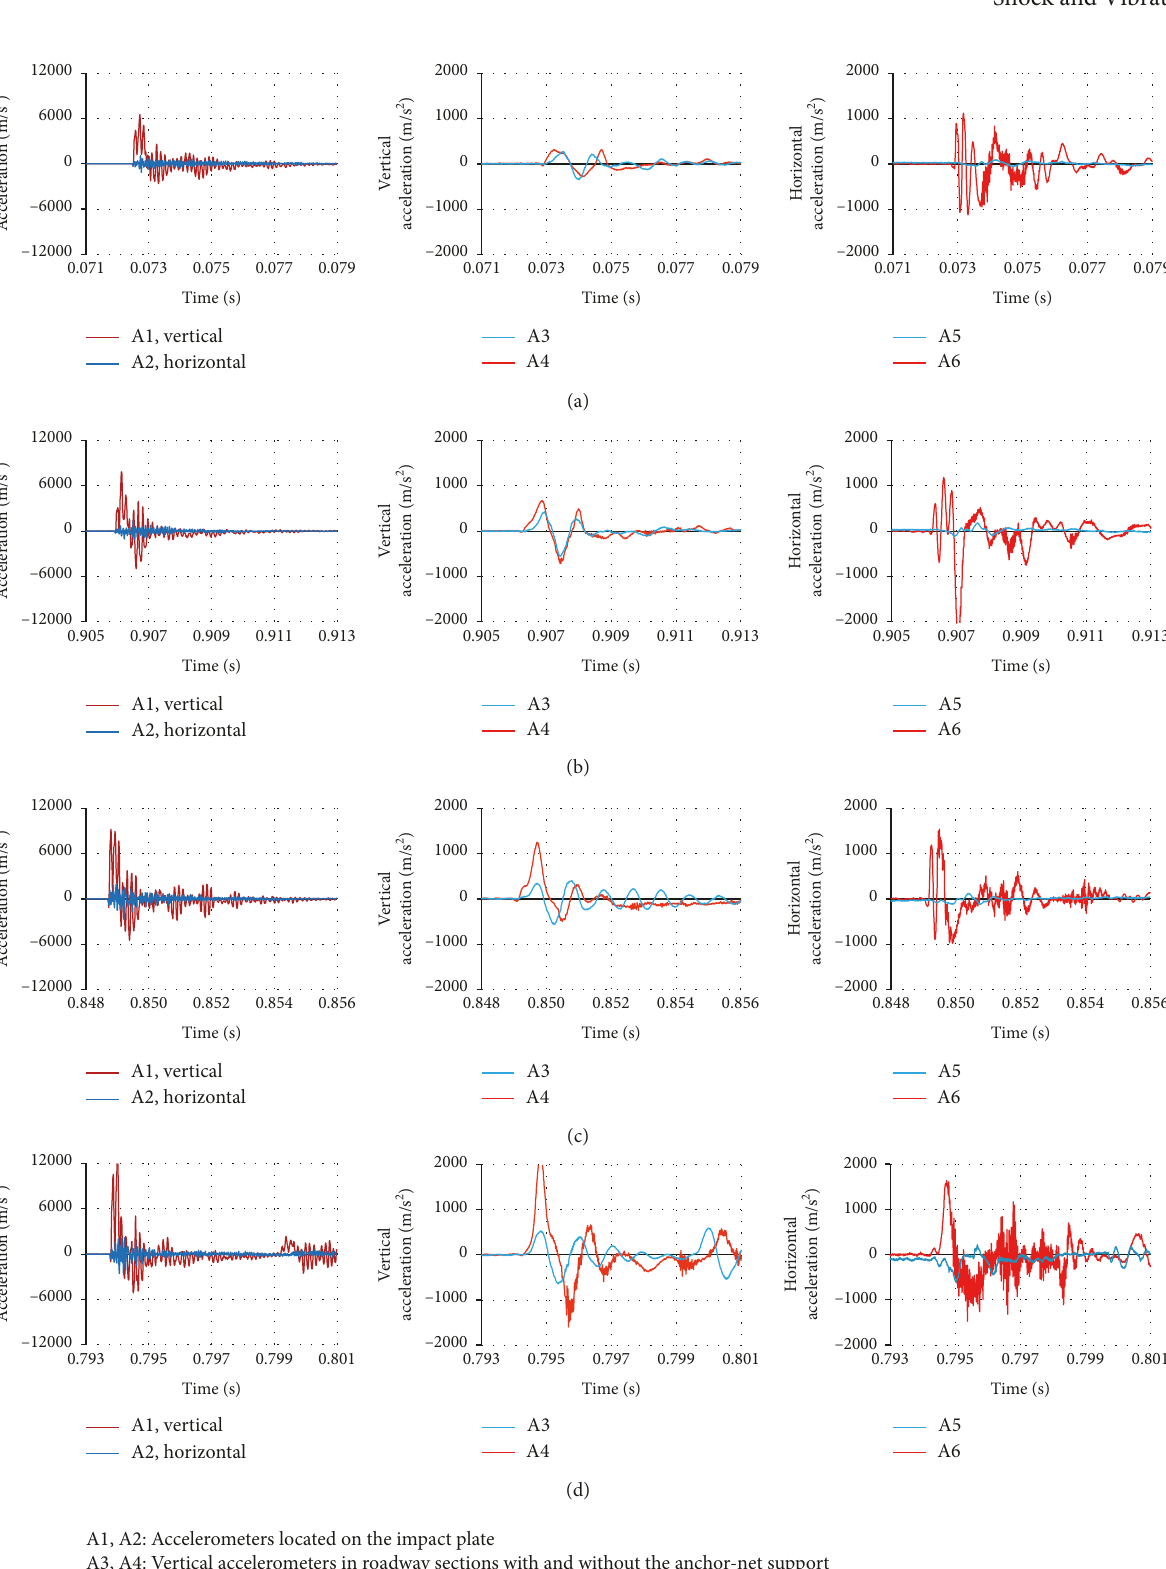
Figure 6: Acceleration signals in tests with different dynamic loading energy: (a) 39.2J; (b) 78.4J; (c) 117.6J; (d)